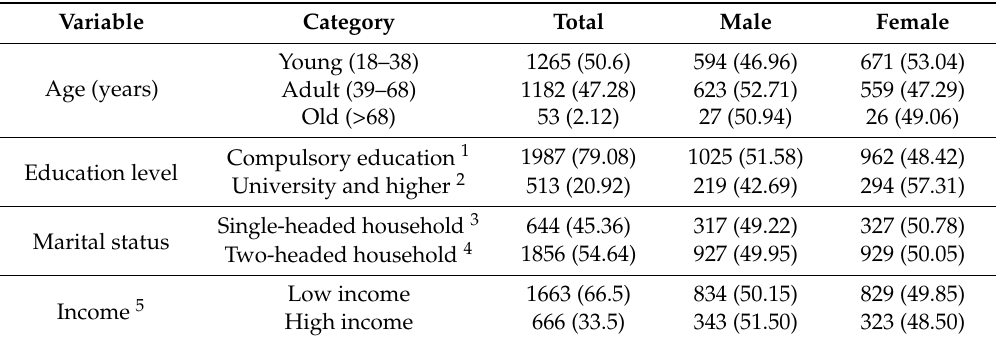
Table 2. Basic socio-economic and demographic information of respondents ( n = 2500) in a gendered classification. In brackets there are percentages. Missing values in the sums correspond to people that did not complete the questionnaire